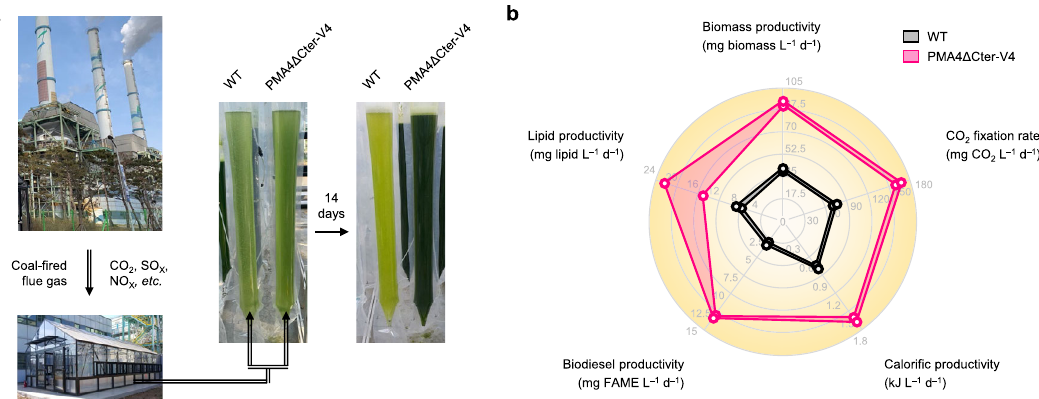
Fig. 4 Proof-of-concept biomass and biofuel production with the engineered strain PMA4 Δ Cter-V4 using coal- fi red fl ue gas. a Bioconversion of CO 2 in the fl ue gas stream emitted from the coal- fi red power plant. A house-manufactured bubble column PBR (10 L of working volume) was employed for cultivation in the vicinity of the coal combustion boiler. b Radar plot showing various cellular performances measured in duplicate ( n = 2). The covered ranges on the axis indicate the standard deviation of each parameter. Source data are provided as a Source Data fi